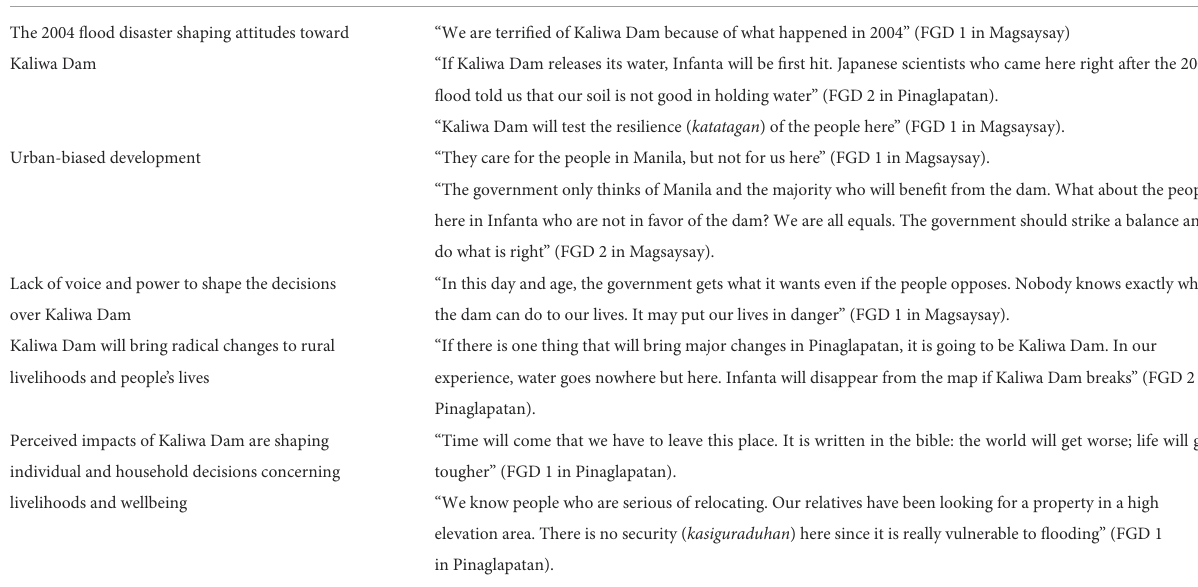
TABLE 2 Local perspectives on Kaliwa Dam in Magsaysay and